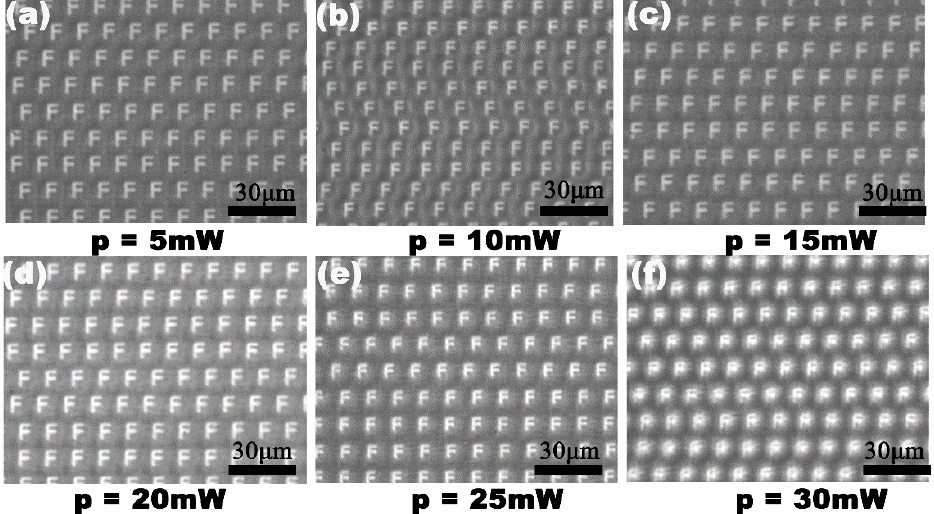
Figure 6. The IR optical performances of the MLAs fabricated at different laser power levels: ( a ) 5 mW; ( b ) 10 mW; ( c ) 15 mW; ( d ) 20 mW; ( e ) 25 mW; ( f ) 30 mW.